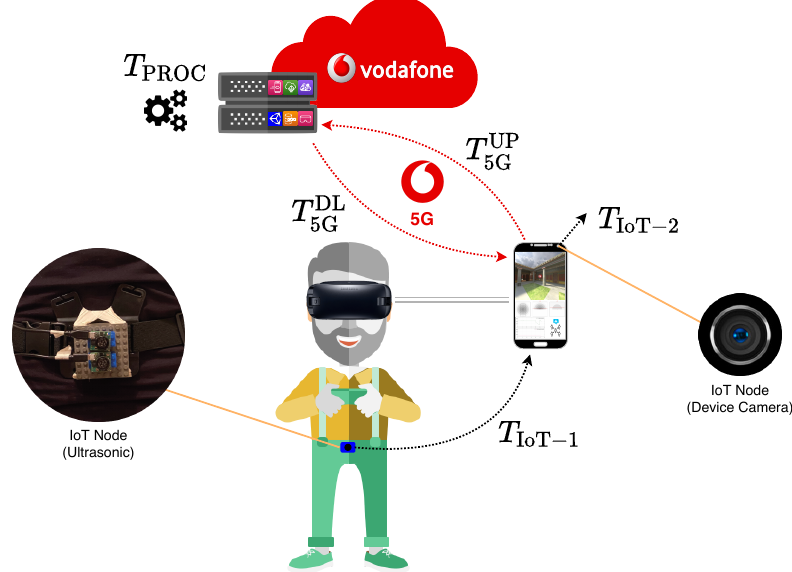
Figure 25. Considered 5G/XR/IoT system